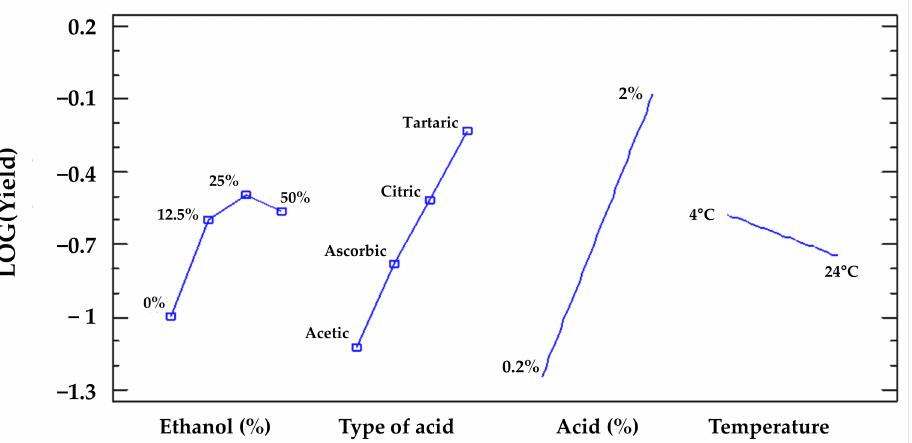
Figure 5. The main effects plot shows changes in response when each of the four categorical factors (temperature, percentage ethanol, type of acid, percentage of acid) is moved from its lowest to its highest